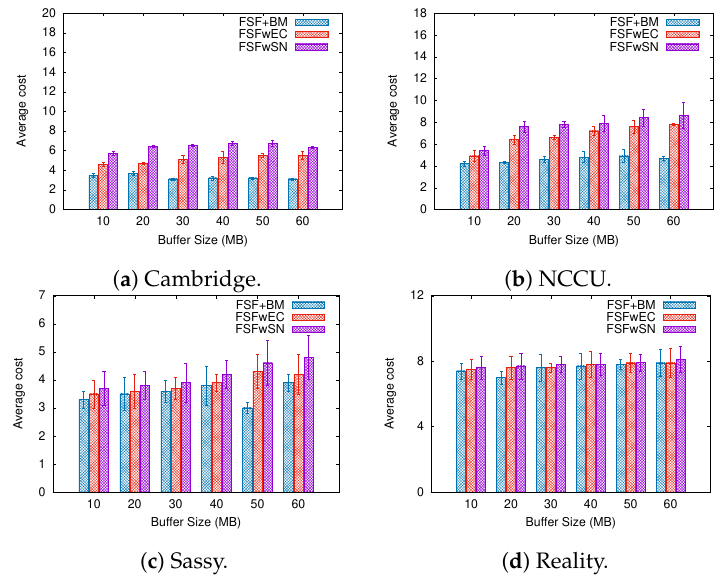
Figure 16. Average Cost when varying the buffer